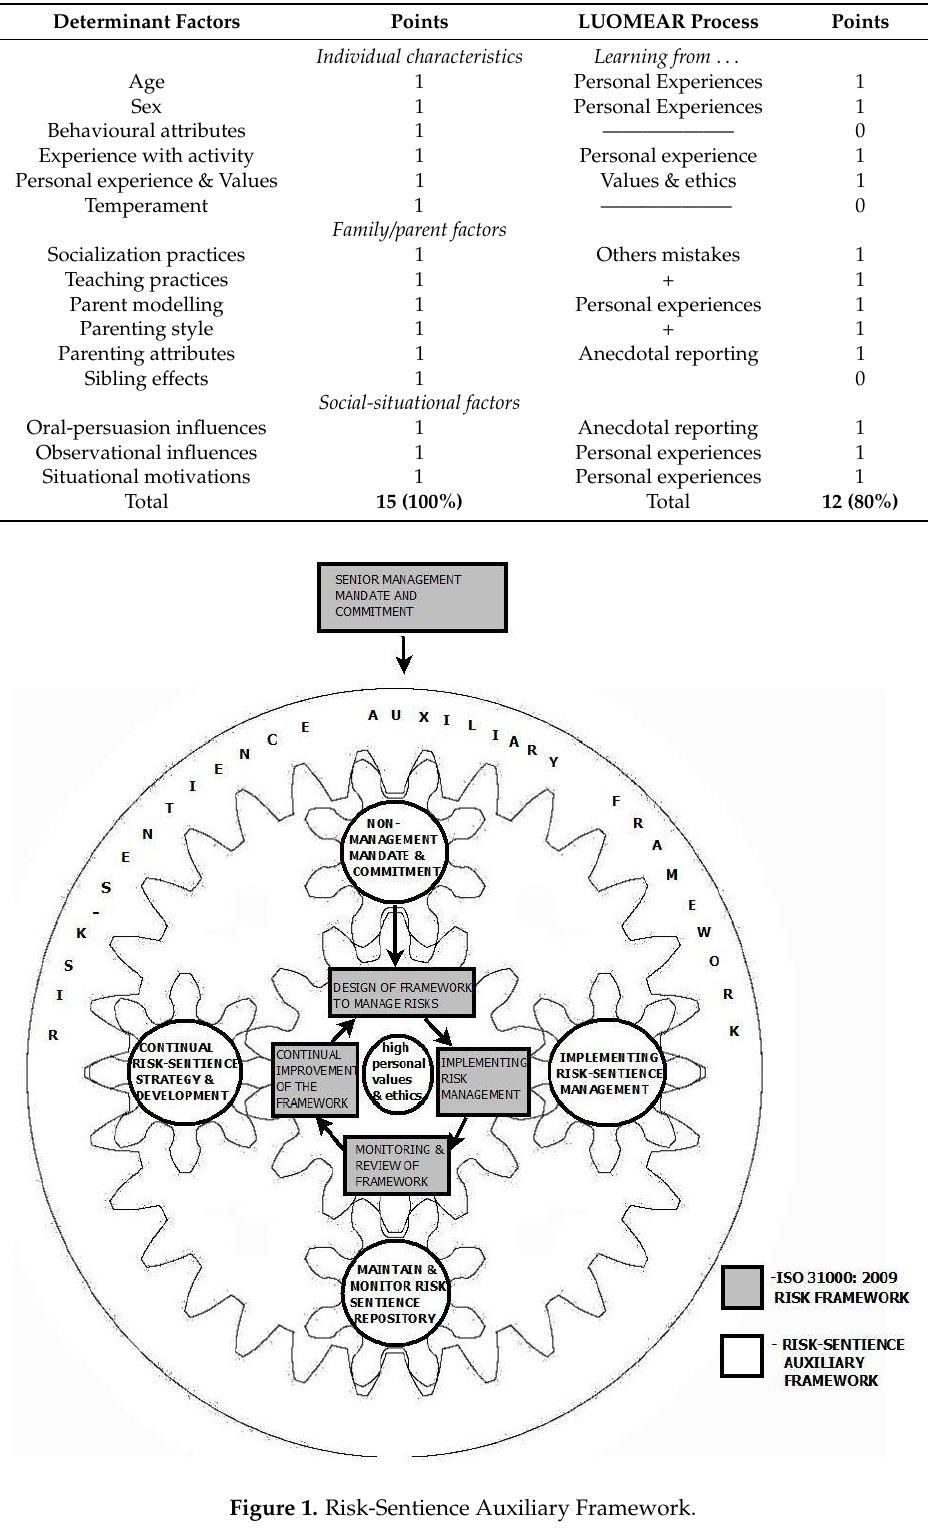
Table 1. Integration of risk-determinants into LUOMEAR (Learning from Uncertainties, Others Mistakes, Experiences and Anecdotal Reporting).